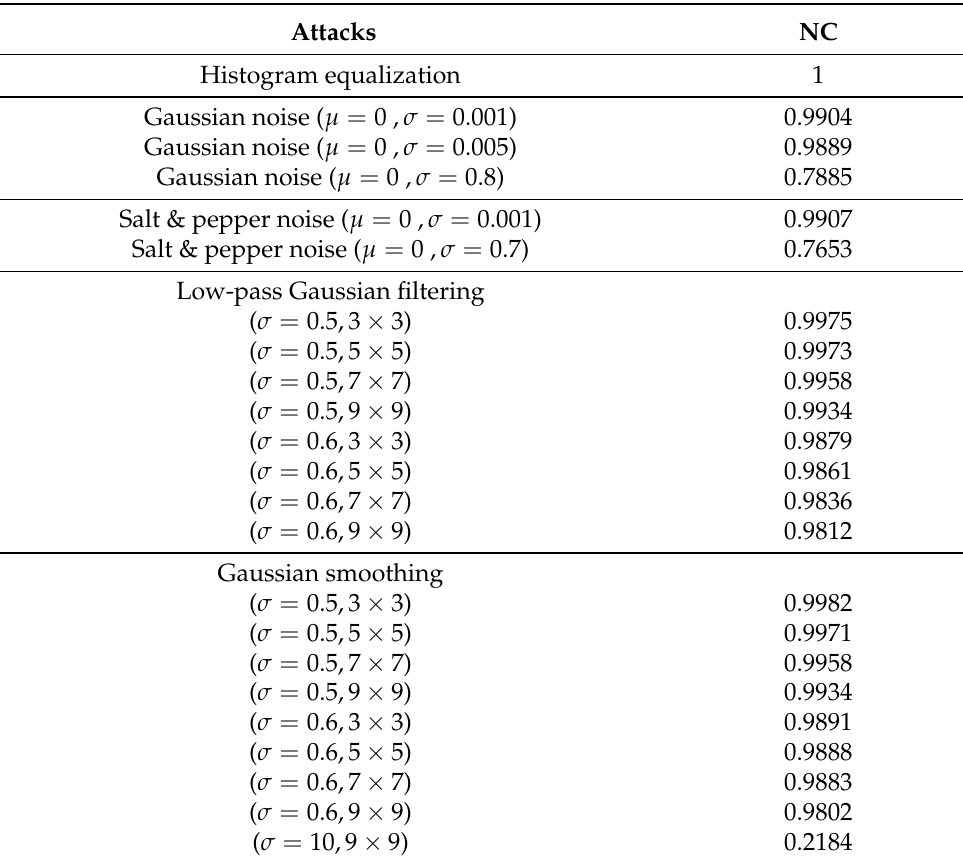
Table A8. Robustness after several attacks applied to thirty test